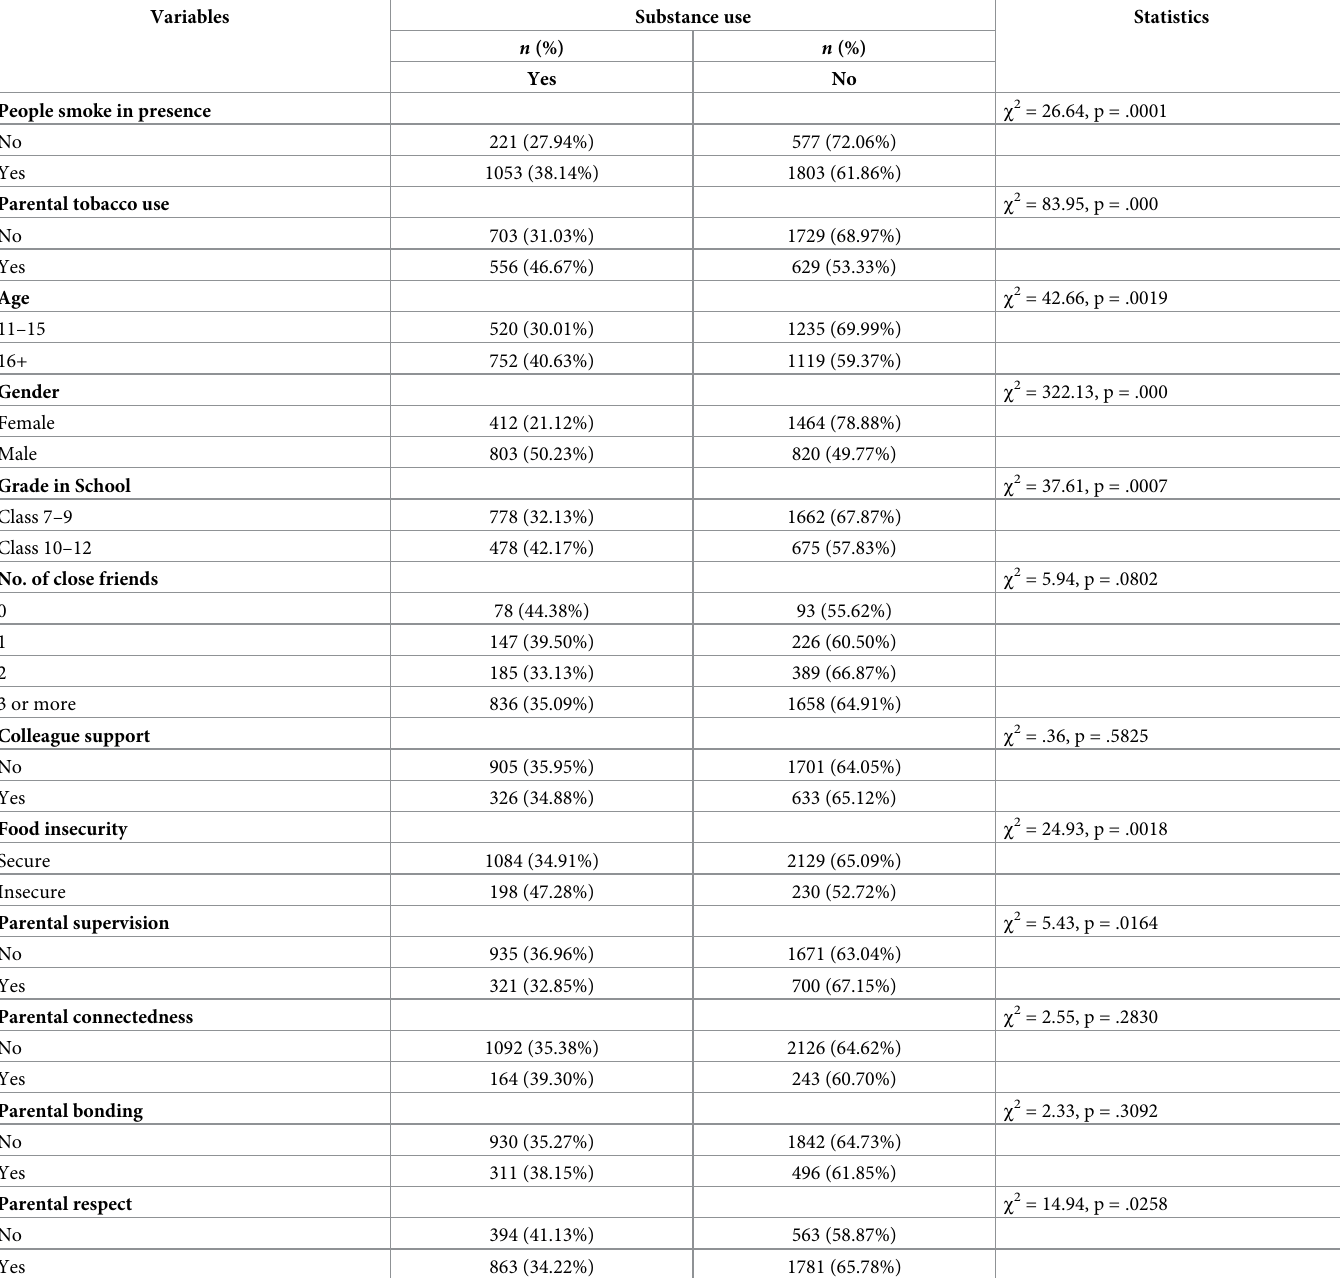
Table 2. Chi-Square examining the relationship between adolescent’ substance use, independent variables and covariates.